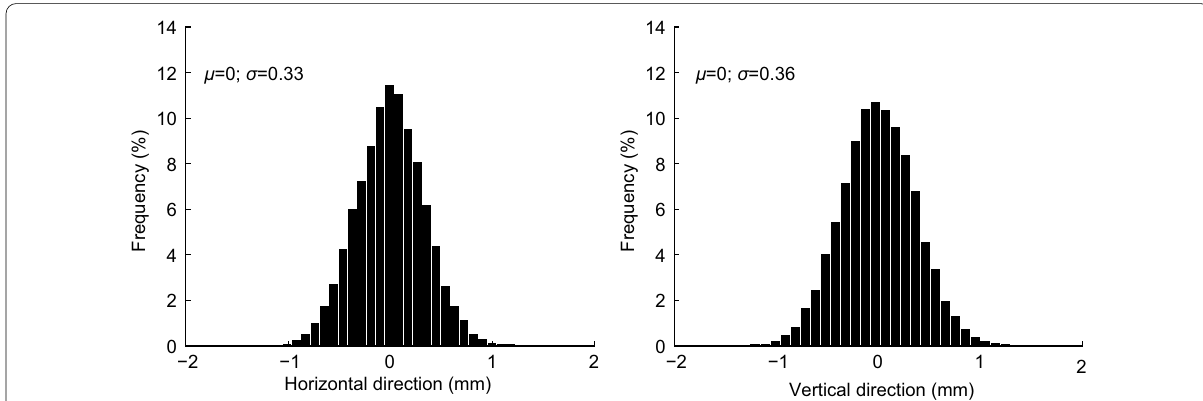
Fig. 6 Histogram of the short-wave track irregularity measurement errors of the aided INS by the simulation method